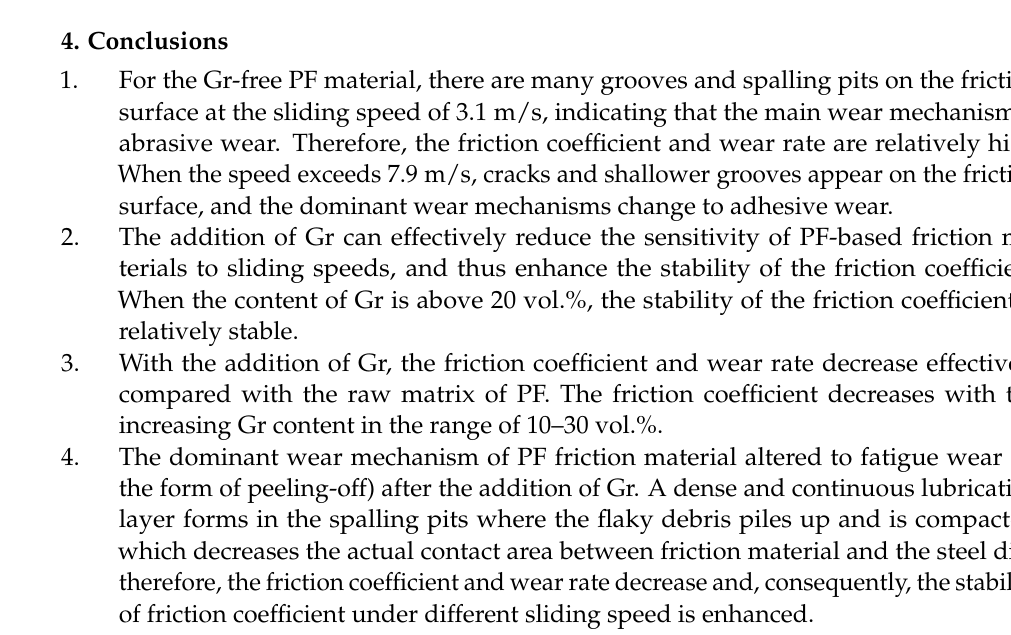
Figure 7. Schematic progress of compact lubricating/transfer film formation: ( a ) PF friction material without the addition of Gr; ( b ) PF friction material with the addition of Gr.